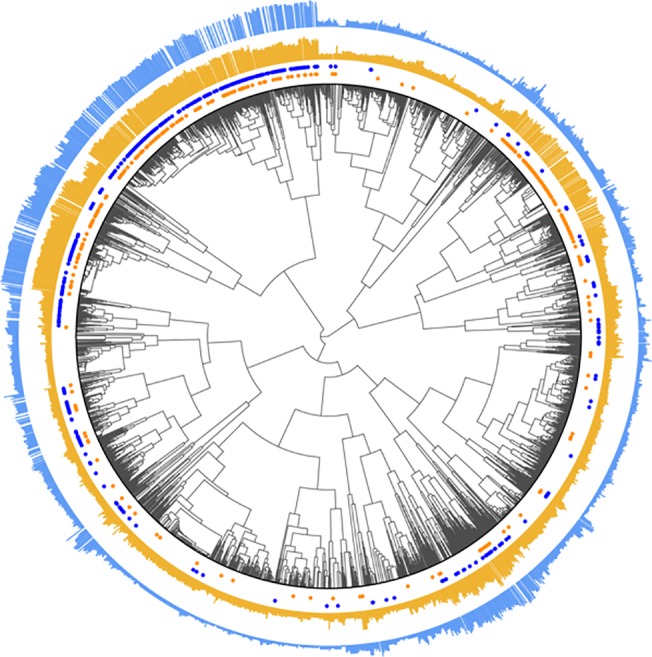
Dendrogram illustrating predictions of novel PGx and drug-target relationships among 3514 drug-gene pairs.The height of the bars corresponds to EBC's certainty that the pair in question represents a relationship of the corresponding type (orange: PGx relationships, blue: drug-target relationships). The dots represent known PGx and drug-target relationships, as in Fig 4.